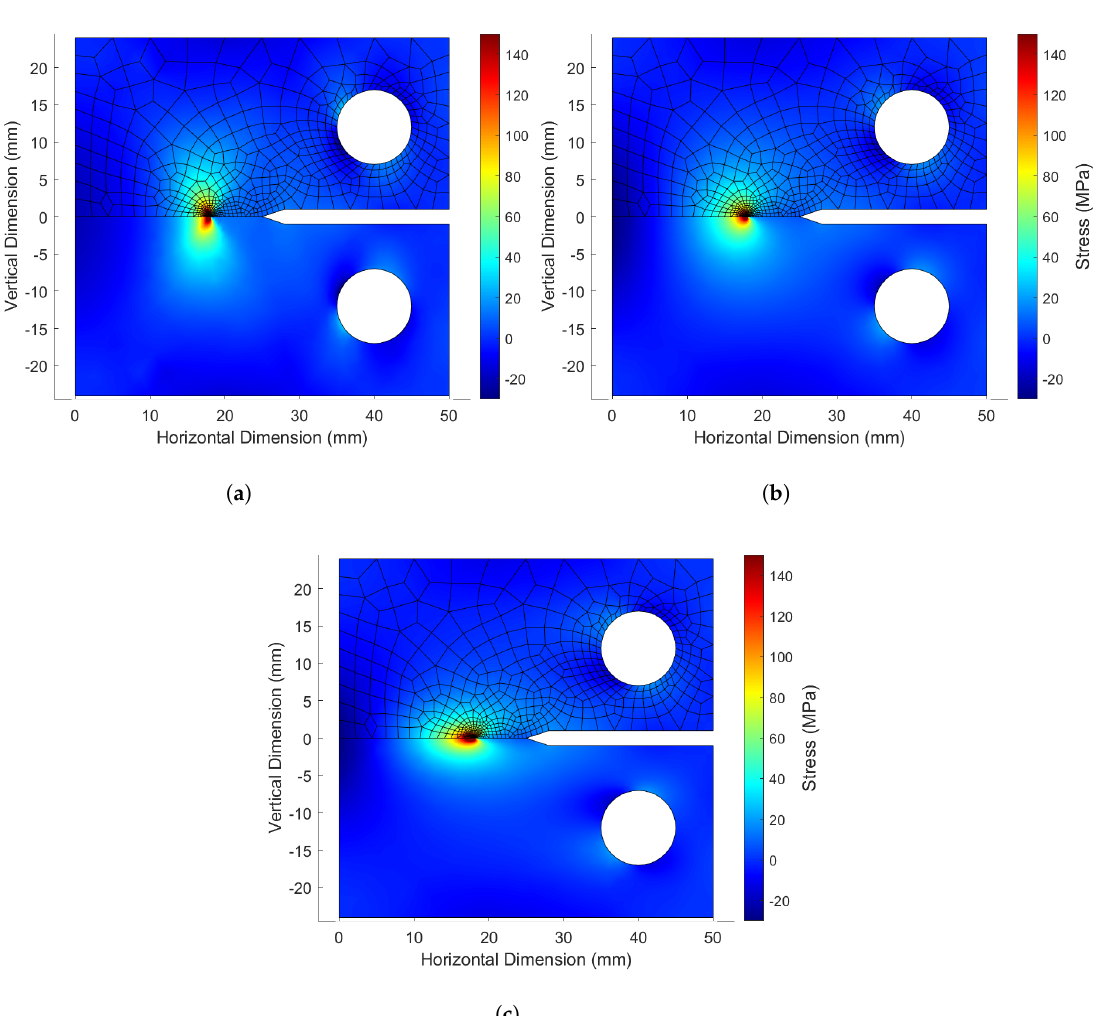
Figure 14. TSA stress distribution maps for f = 20 Hz and various values of elastic